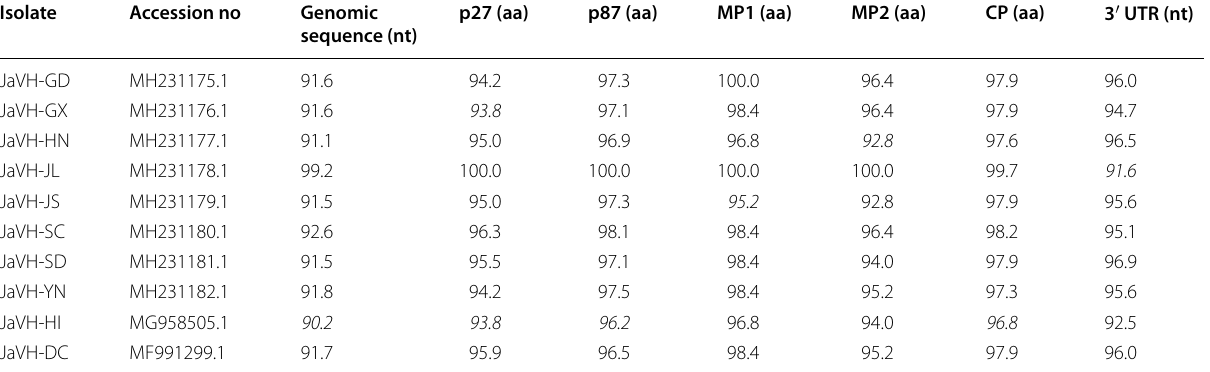
Table 1 Percent nucleotide (nt) and amino acid (aa) sequence identity between jasmine virus H Fujian isolate and ten other isolates